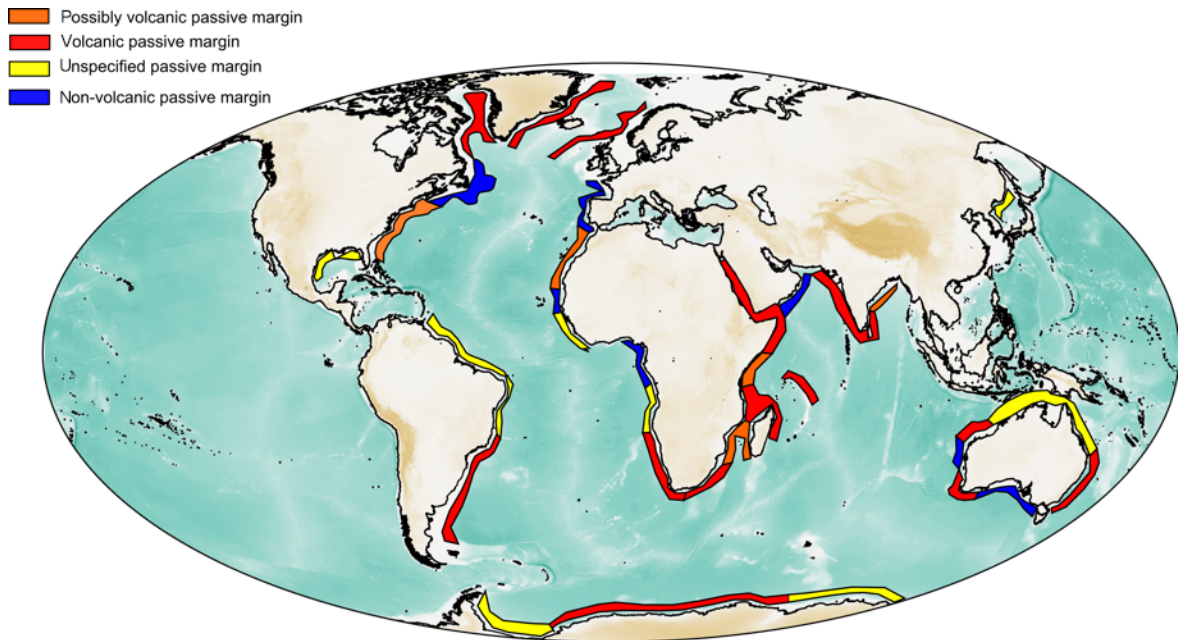
Figure 1. Distribution of the different types of passive margins around the world. The northeast Atlantic rifted margins are the type examples of volcanic rifted margins. Compiled from Menzies et al. (2002), Geoffrey (2005), Haupert et al. (2016), Jones et al. (2016), and Brune et al.